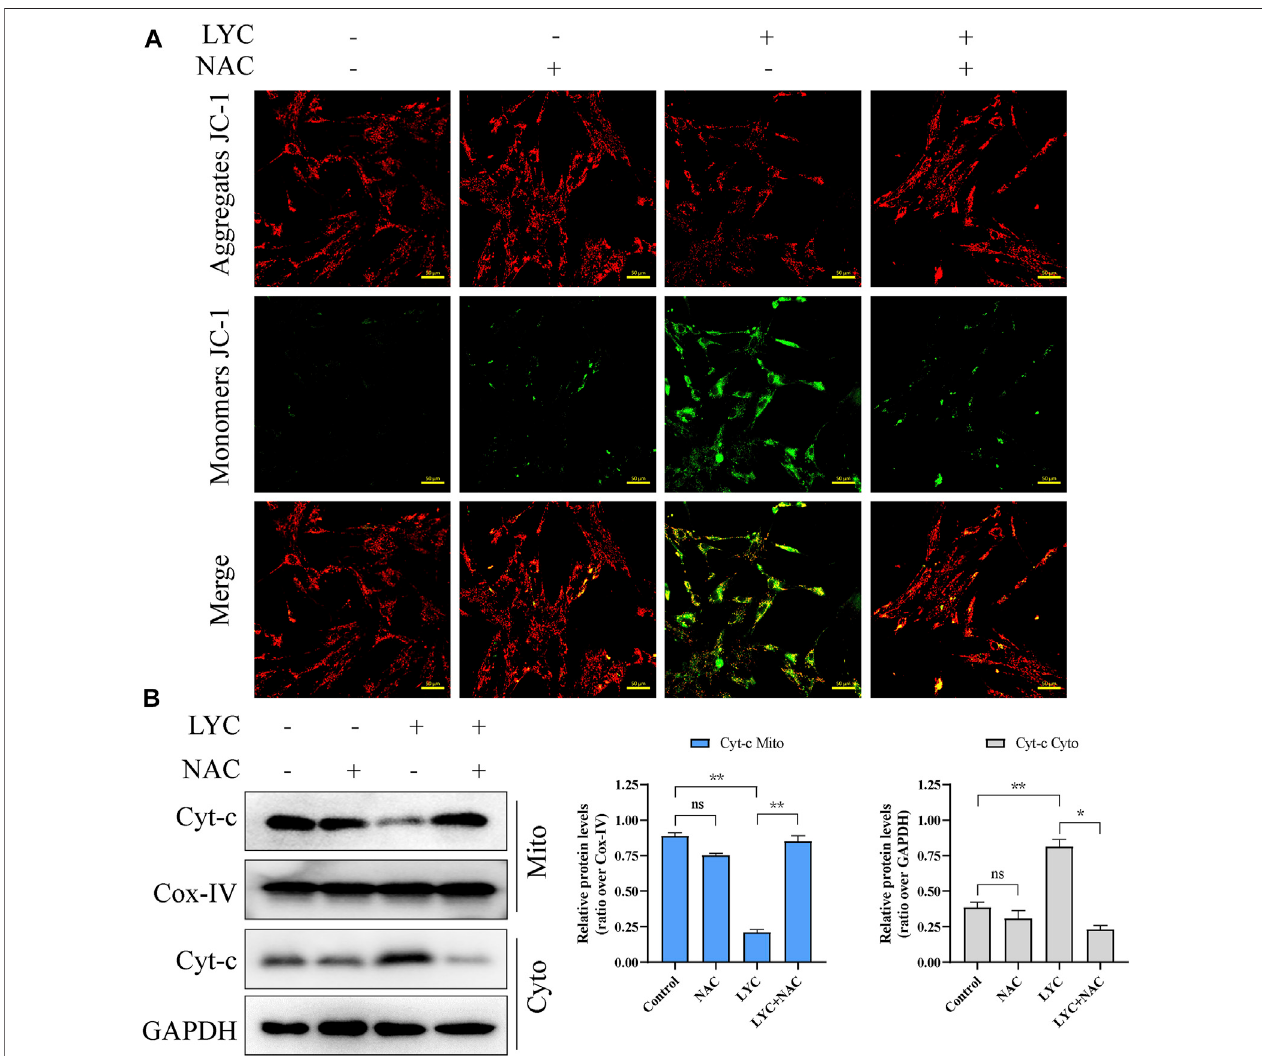
FIGURE5| HighlevelsofROSinducedbylycorinealtersthemitochondrialmembranepotential(MMP)andcytochromeC(cyt-C)translocation.HSFsweretreated with vehicle (control) or 40 μ M lycorine in the presence or absence of 100 μ M NAC for 24 h. (A) The MMP was analyzed by fl uorescence microscopy after staining with JC-1( n =3).Scalebar:400 μ M. (B) ThelevelsofCytochromeC(cyt-C)inthebothcytoplasmandmitochondriawereexaminedbyWesternblot( n =3).Dataaremean± standard error of the mean. * p < 0.05, ** p < 0.01, *** p < 0.001.